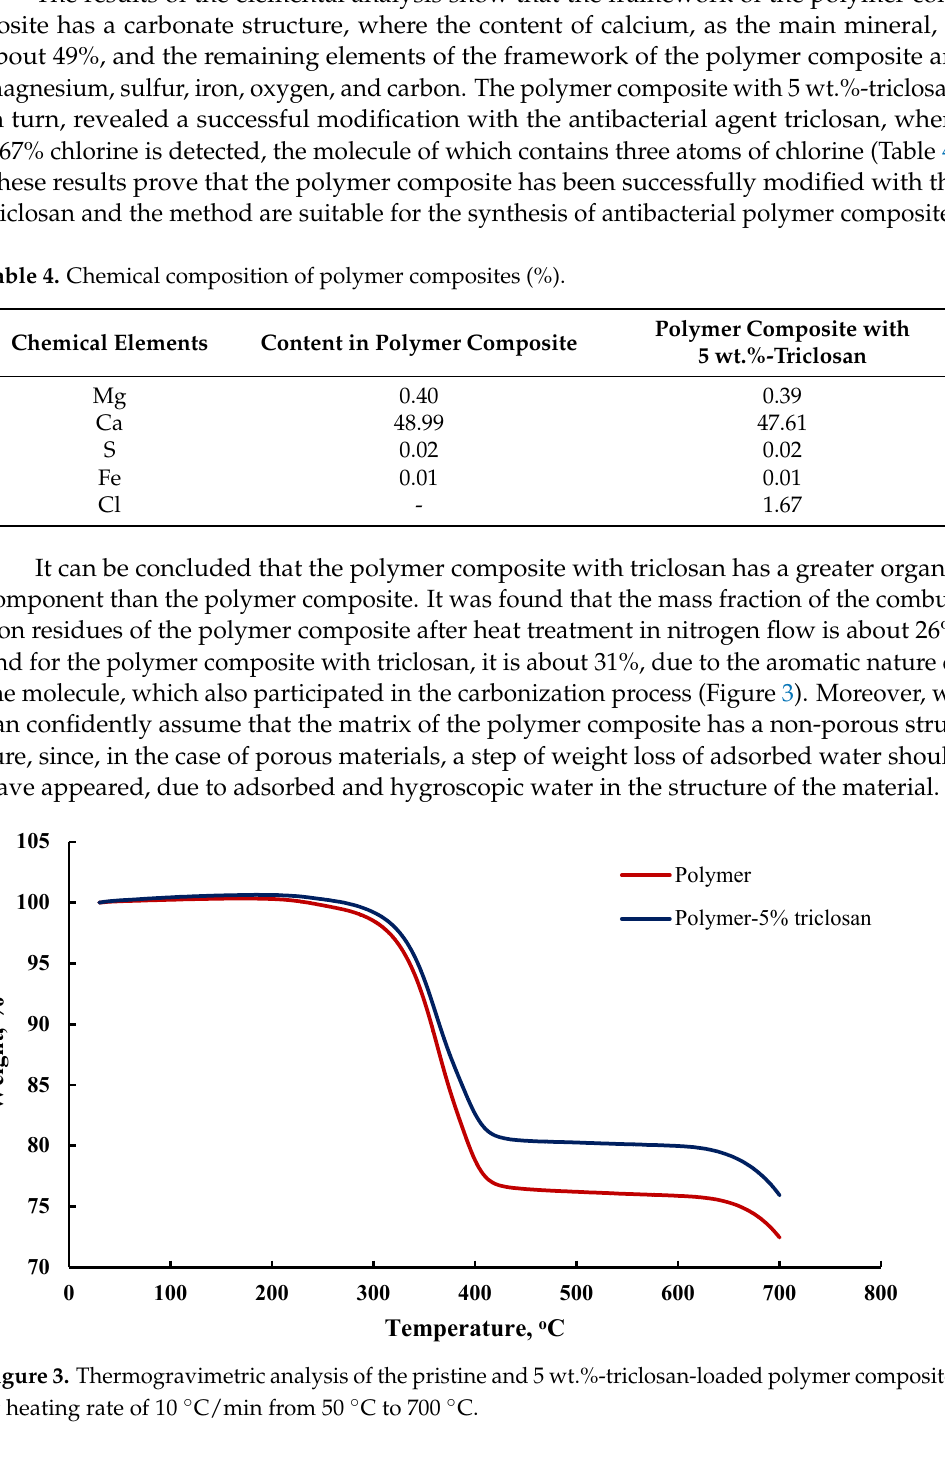
Table 4. Chemical composition of polymer composites (%).